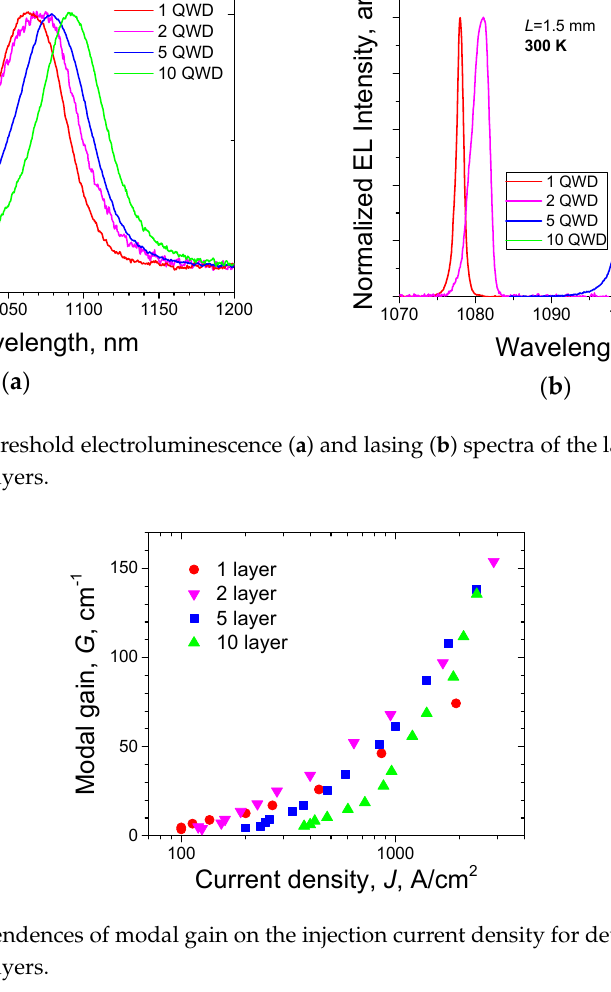
T 0 =163K Figure 13. Temperature dependence of the threshold current of QWD-based laser. We note that stacking as many as 10 layers of QWD without any strain compensation, does not deteriorate the device performance (Table 2) as could be expected for QWs. To estimate the relative effect of non-radiative recombination centers on device performance, we studied the dependence of integrated electroluminescence intensity on injection current in lasers based on 1 and 10 QWD layers. The current component associated with the radiative recombination is characterized by a linear dependence of the integrated intensity on the injection current, whereas the non-radiative component is characterized by the quadratic dependence (Figure 14). At low injection levels, the non-radiative